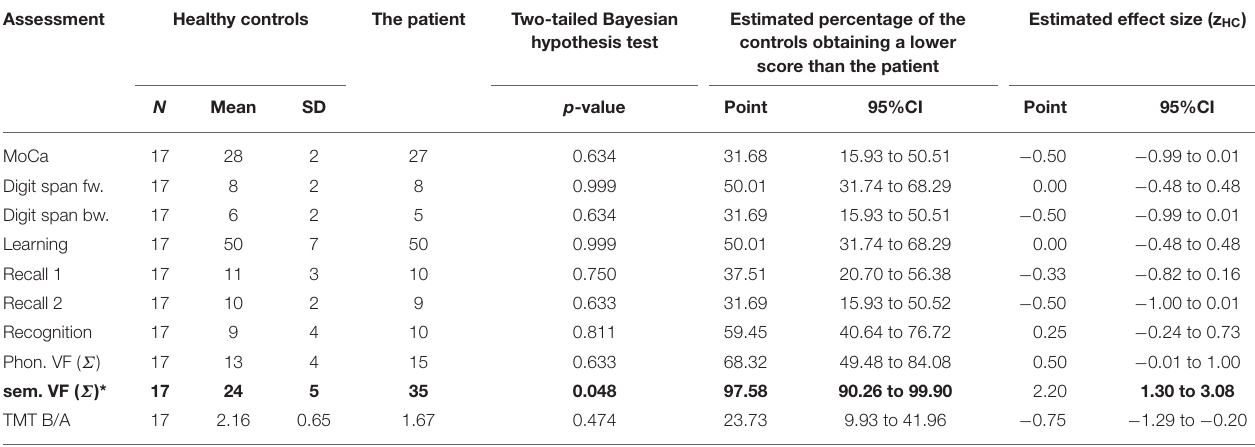
TABLE 1 | The patient’s cognitive abilities at his baseline neuropsychological examination. Assessment Healthy controls The patient Two-tailed Bayesian